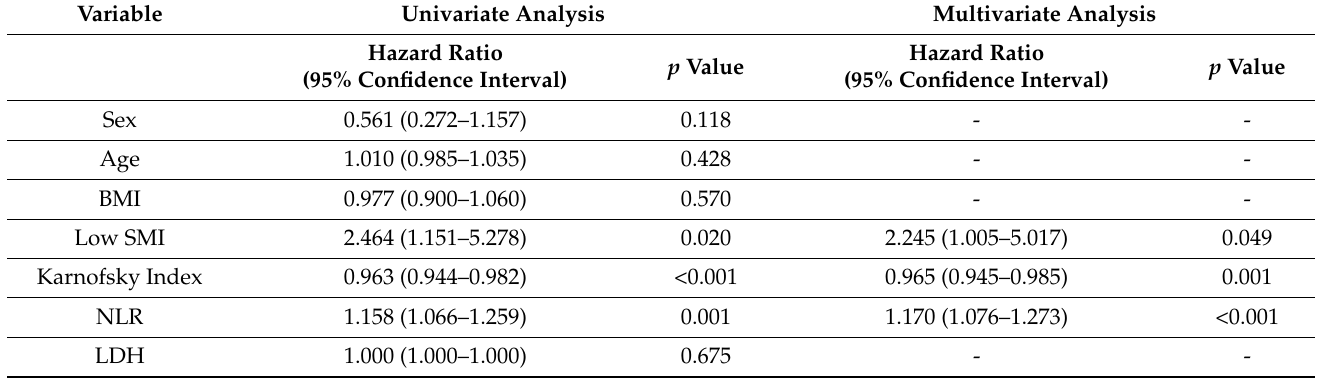
Table 3. Predictors of 3-year mortality in melanoma patients receiving immune checkpoint inhibitor therapy. Predictors were determined using Cox regression analysis. Variables that were significantly associated with 3-year mortality on univariate analysis were entered to the multivariable model using stepwise forward selection. Hazard ratios are provided with 95% confidence interval. Abbreviations: NLR, neutrophil-to-lymphocyte ratio; SMI, skeletal muscle index; BMI, body mass index; LDH, lactic acid